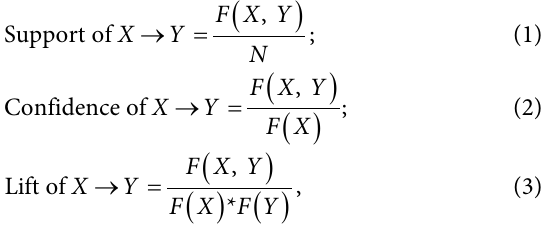
same time, F ( X ) and F ( Y ) are the frequency of X and Y ,